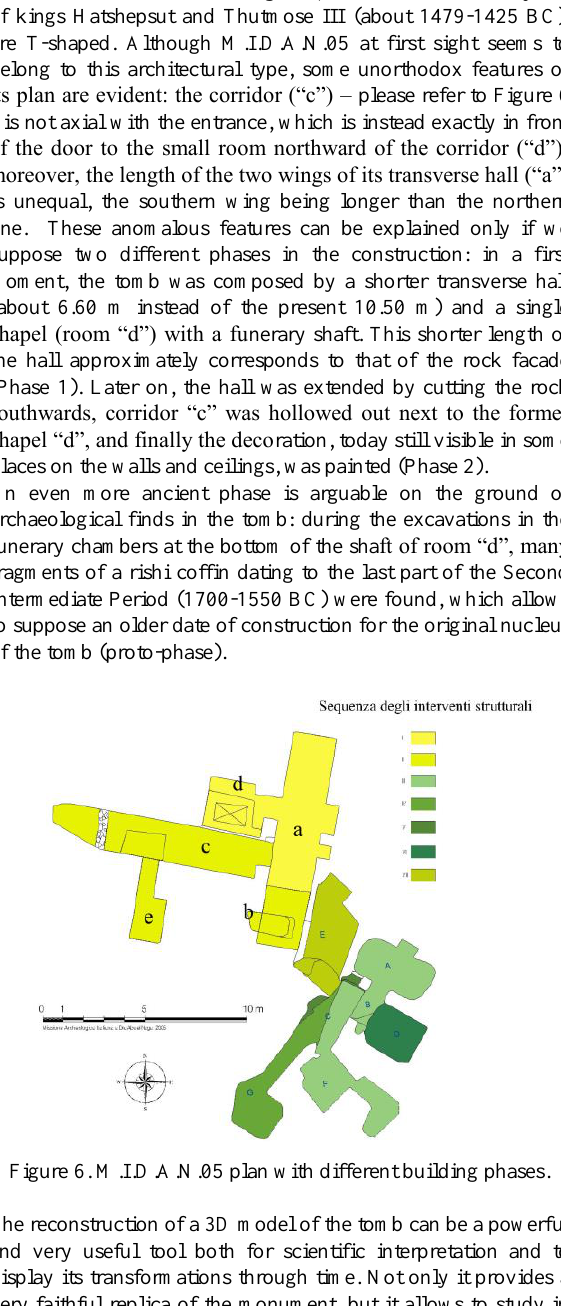
Figure 5. Colours acquired by the scanner (top), and colours projected from external camera images (bottom).